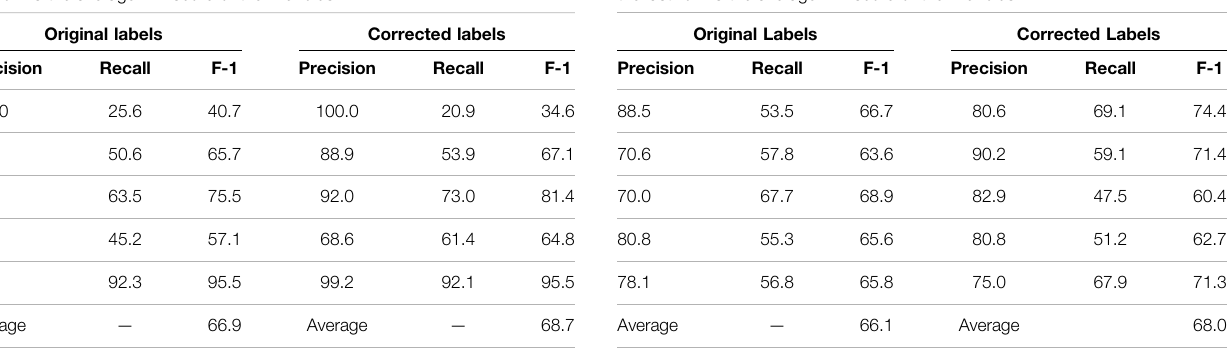
TABLE 1 | K-fold ( K (cid:1) 5) validation of the SpaCy model on 96 paragraphs with original vs. corrected labels. The fi rst fi ve rows are the results of each fold; the last row is the average F-1 score of the fi ve folds.